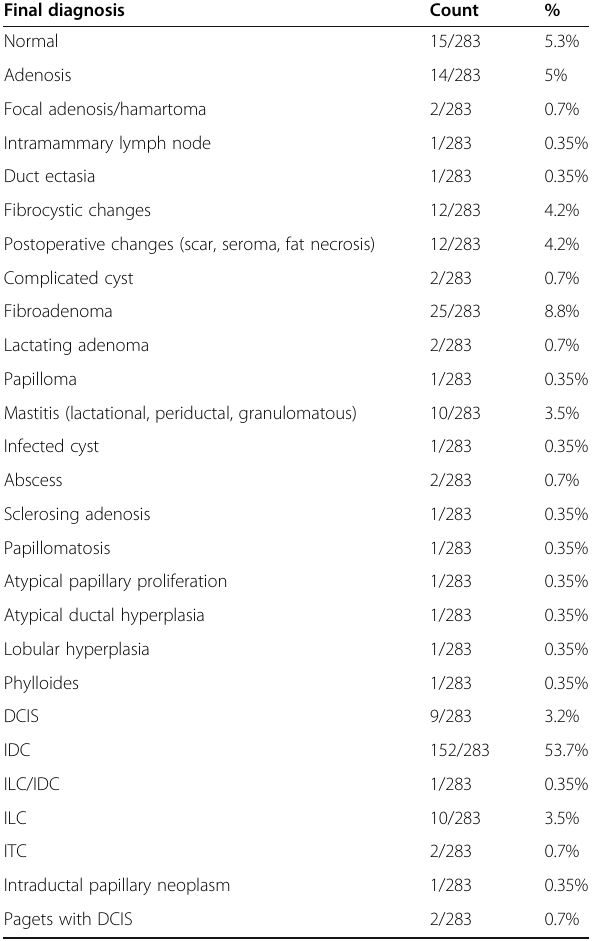
histopathology or ultrasound findings with routine follow-up